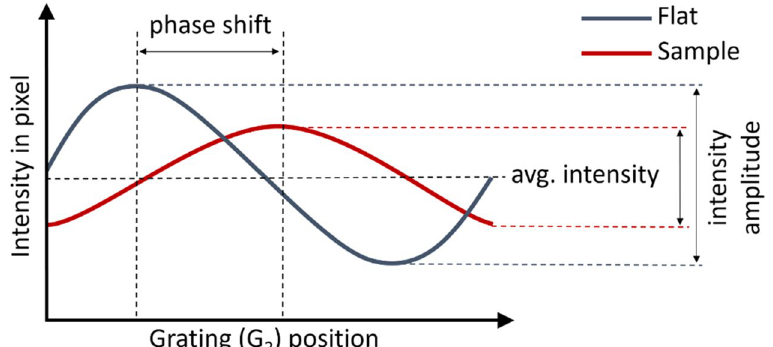
Figure 2. The phase stepping curve for one pixel plots the intensity oscillation measured in that pixel as a function of the distance moved by G 2 parallel to G 1 , perpendicular to the X-ray beam. ‘Flat’: no sample is placed in the grating interferometry setup, ‘Sample’: sample is placed in the